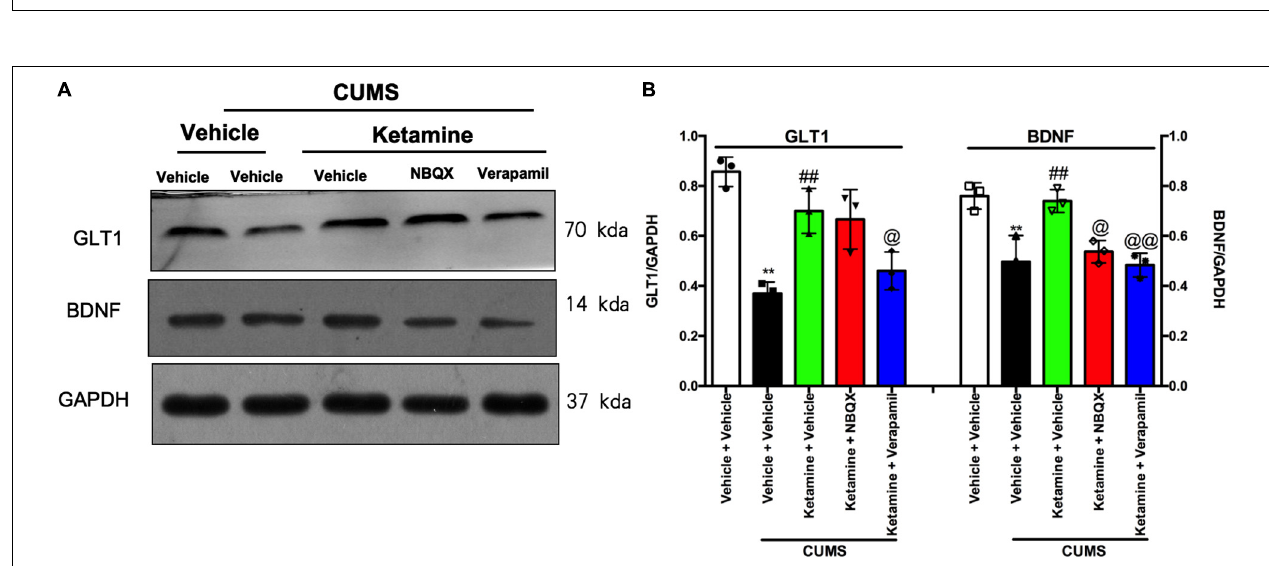
FIGURE 5 | The roles of AMPAR and L-VDCC in the regulation of Ketamine on GLT1 and BDNF in the PFC of mice. GLT1 and BDNF protein expression were determined by Western blot. Representative western blot (A) and quantification (B) of fold changes in the protein levels of GLT1, and BDNF in the PFC of mice. The data are expressed as means ± SEM; n = 3; ** P < 0.01 compared with vehicle + vehicle + non-stressed group; ## P < 0.01 compared with vehicle + vehicle + CUMS group; @ P < 0.05, @@ P < 0.01 compared with ketamine + vehicle + CUMS group.